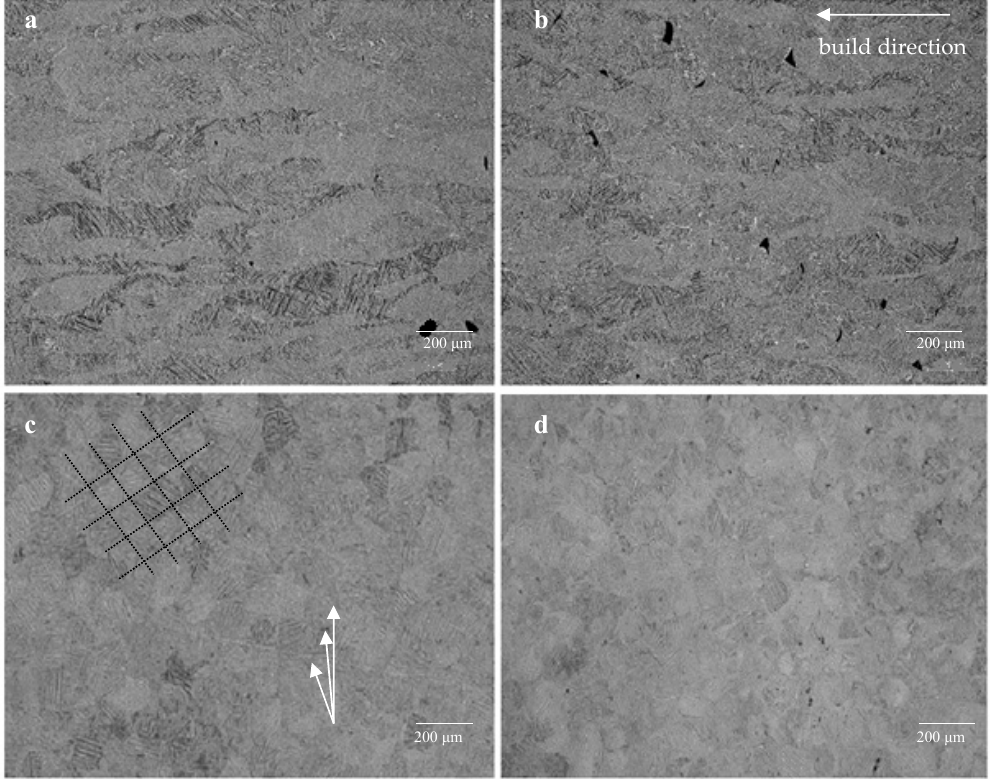
Figure 5. Cross-sections perpendicular ( a , b ) and parallel with deposited layers ( c , d ) before ( a , c ) and after ( b , d ) heat treatment, revealing microstructure of the as built ( a , c ) and annealed sample ( b , d ); mag. 100×.